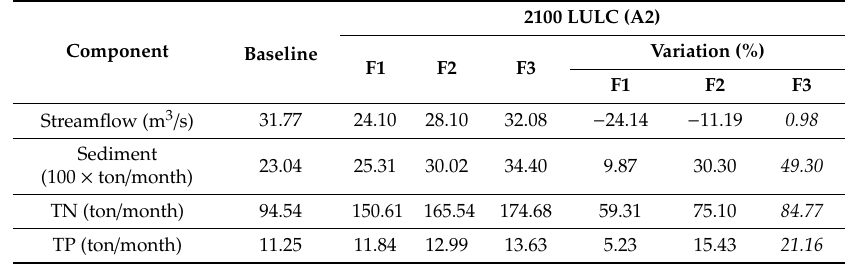
Table 6. Future streamflow and water quality variation (Sediment, TN, and TP) associated with the RCP8.5 climate scenario in three di ff erent time windows (F1: 2021–2045, F2: 2046–2070, F3: 2071–2095), as opposed to the baseline period